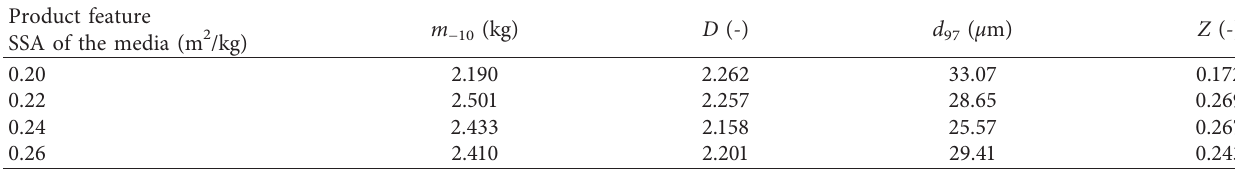
Table 2: Variation of product features at different SSAs of the